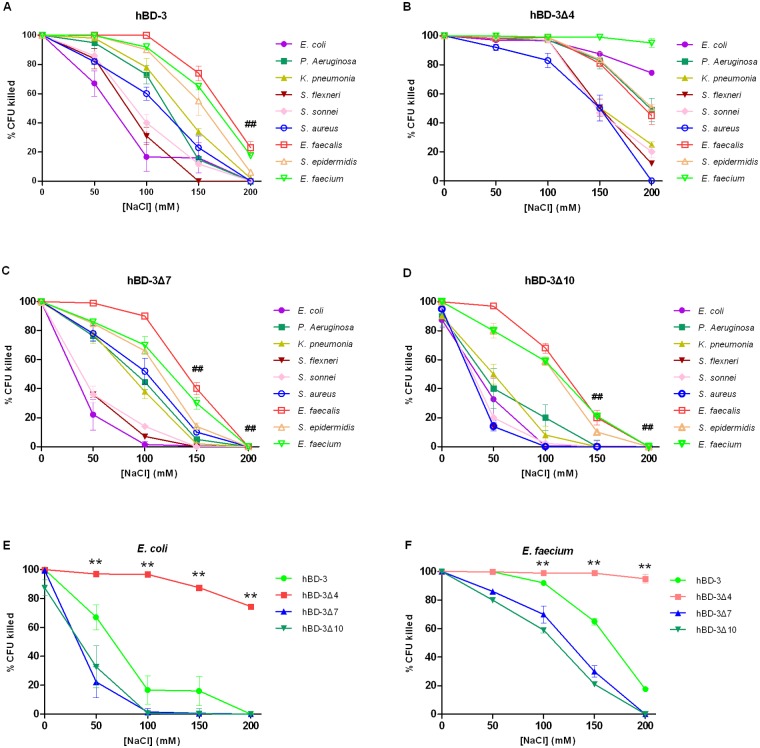
Antibacterial activity at increasing NaCl concentrations of hBD-3 (A), hBD-3Δ4 (B), hBD-3Δ7 (C) and hBD-3Δ10 (D) against nine bacterial strains or species; and of hBD-3 and analogs against E. coli ATCC 25922 (E) and E. faecium ATCC 6057 (F).Error bars show the SDs of experiments performed in triplicate. Non parametric tests were used in the statistical analysis. ** Significantly different (P < 0.01) from the activity of wild-type hBD-3. ## Significantly different (P < 0.01) from the activity of hBD-3 at 0 mM NaCl.